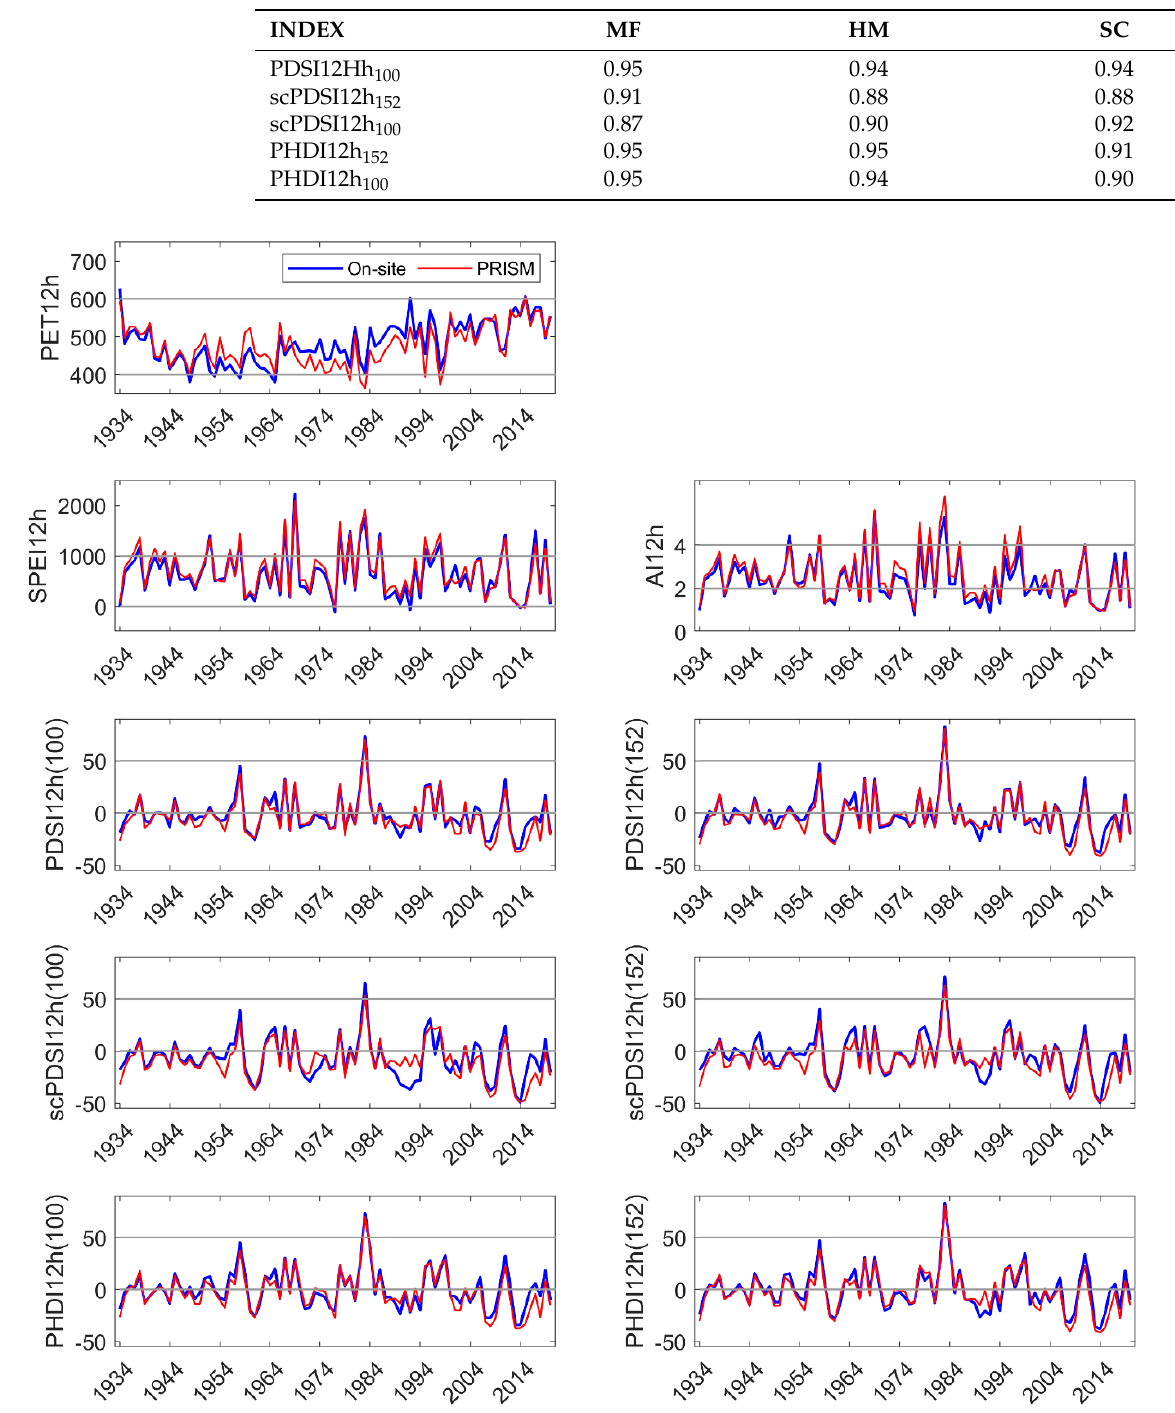
Figure 3. On-site vs. PRISM parameterization of PET and each drought index calculated for the hydrologic year.